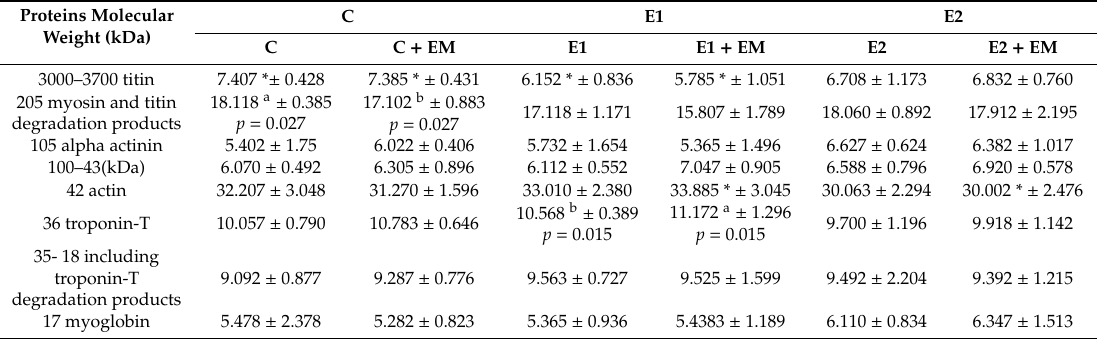
Table 5. Percentage of muscle proteins in longissimus lumborum obtained through electrophoretic separation on polyacrylamide gels with SDS